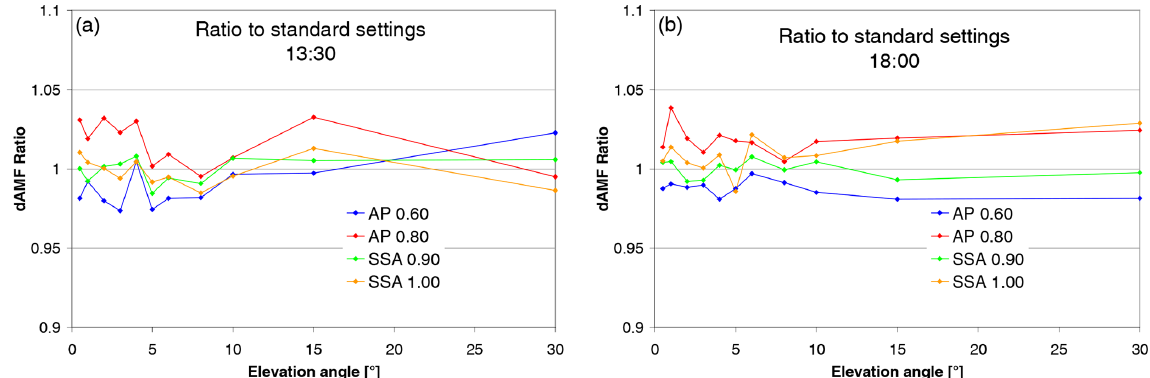
Figure A8. Effect of different phase functions and single scattering albedos on the O 4 dSCDs. Shown are the ratios for simulations with variations of asymmetry parameter (AP) and single scattering albedo (SSA) versus simulations using the standard settings (AP: 0.68, SSA: 0.95). The results are for SZA of 33.6 ◦ and RAA of 0.7 ◦ (left, around 13:30UTC) and SZA of 64.5 ◦ and RAA of 87.7 ◦ (right, around